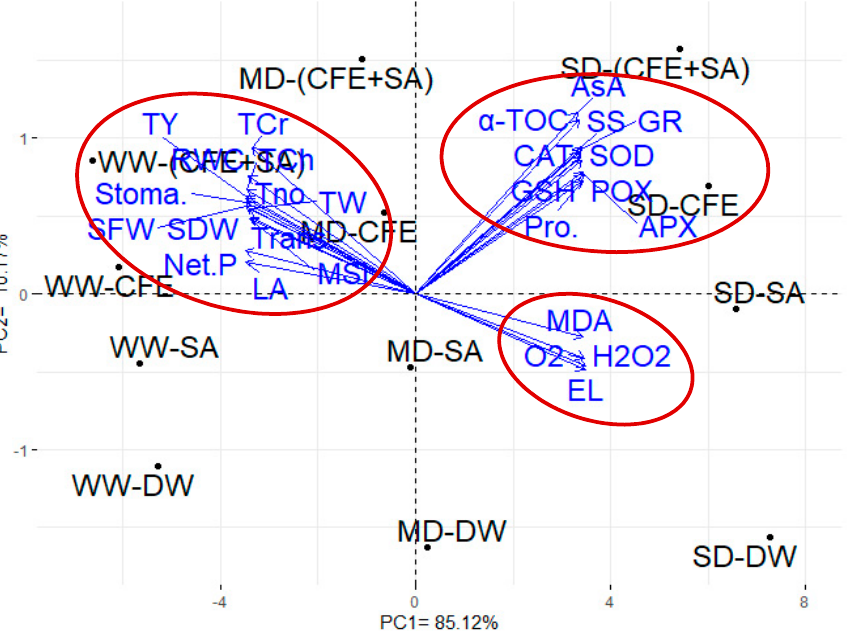
Figure 2. Biplot of the first two principal components for the morphological, yield, and physiochemical traits of potato plants. The morphological parameters comprised shoot fresh weight (SFW), shoot dry weight (SDW), and leaf area (LA). The yield parameters included tuber number (Tno), average tuber weight (TW), and total yield (TY). The phys- iochemical parameters comprised total chlorophyll (TCh), total carotenoid (TCr), net photo- synthetic rate (Net.P), transpiration rate ( Trans. ), stomatal conductance (Stoma . ), relative water content (RWC), membrane stability index (MSI), and electrolyte leakage (EL), in addi- tion to malondialdehyde (MDA), superoxide (O 2• − ), hydrogen peroxide (H 2 O 2 ), proline (Pro.), solu- ble sugars (SS), α -tocopherol ( α -TOC), ascorbic acid (AsA), glutathione (GSH), peroxidase (POX), catalase (CAT), ascorbate peroxidase (APX), superoxide dismutase (SOD), and glutathione reduc- tase (GR). WW-DW, WW-SA, WW-CFE, and WW-CFE+SA were foliar applications using distilled water, salicylic acid , clove fruit extract, and salicylic acid + clove fruit extract under the well-watered treatment s , respectively. MD-DW, MD-SA, MD-CFE, and MD-CFE+SA were foliar applications using distilled water, salicylic acid , clove fruit extract , and salicylic acid + clove fruit extract under the moderate- drought treatment s , respectively. SD-DW, SD-SA, SD-CFE, and SD-CFE+SA were foliar applications using distilled water, salicylic acid , clove fruit extract, and salicylic acid + clove fruit extract under the severe- drought treatment s , respec- tively. 4. Discussion Drought is a serious environmental factor that threatens food security globally. Cli- mate change increases temperatures and decreases rainfall, and thus increases the inci- dence of drought, especially in arid and semi-arid regions [60]. This diminishes the avail- ability of water needed by plants, leading to severe weakness in growth and affecting the